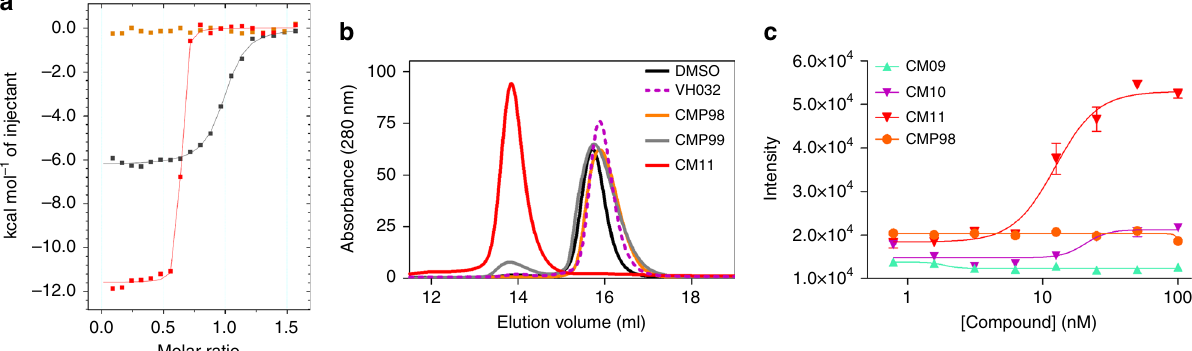
Fig. 7 Biophysical studies of Homo-PROTACs binding to VHL. a Superposition of the integrated ITC heat curves of CM11 (blue), CMP99 (black) or CMP98 (green) titrations against VCB. b SEC assay of complex formation after incubation of CM11 (red), CMP98 (pale green), CMP99 (purple), VH032 (dotted purple) or DMSO (black) with VCB. c AlphaLISA: intensity values titrating CM09, CM10, CM11 and CMP98 against VCB. Each point is mean ( ±